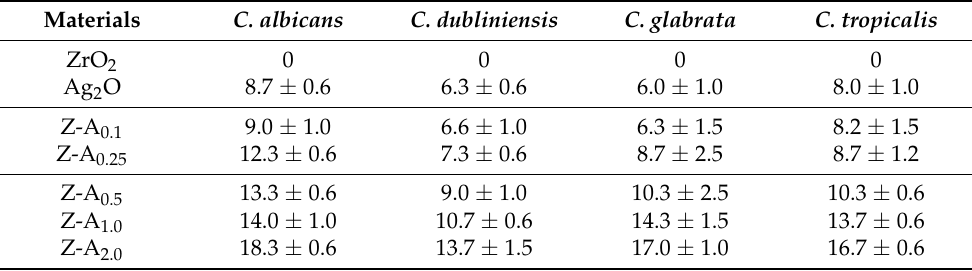
Table 1. Zone of inhibition in (mm) formed on the different fungus by the different synthesized materials.